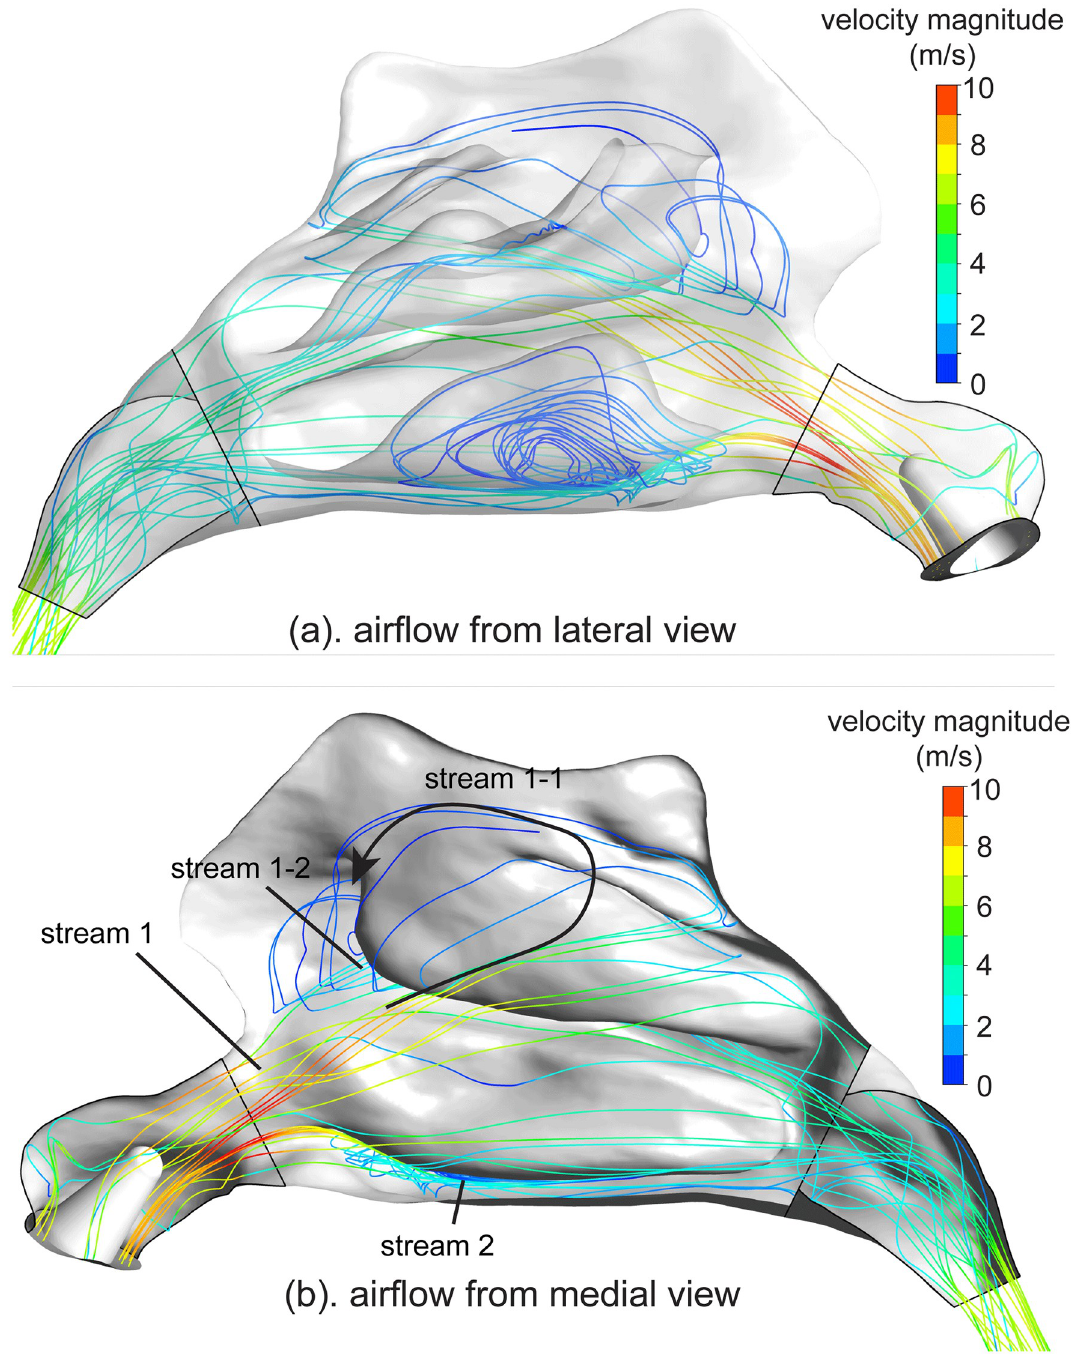
Fig 4. Airflow streamlines passing through the right chamber of the human nasal cavity. Streamlines are coloured with velocity magnitude. a). lateral view with transparent nasal walls. b). medial view with septum